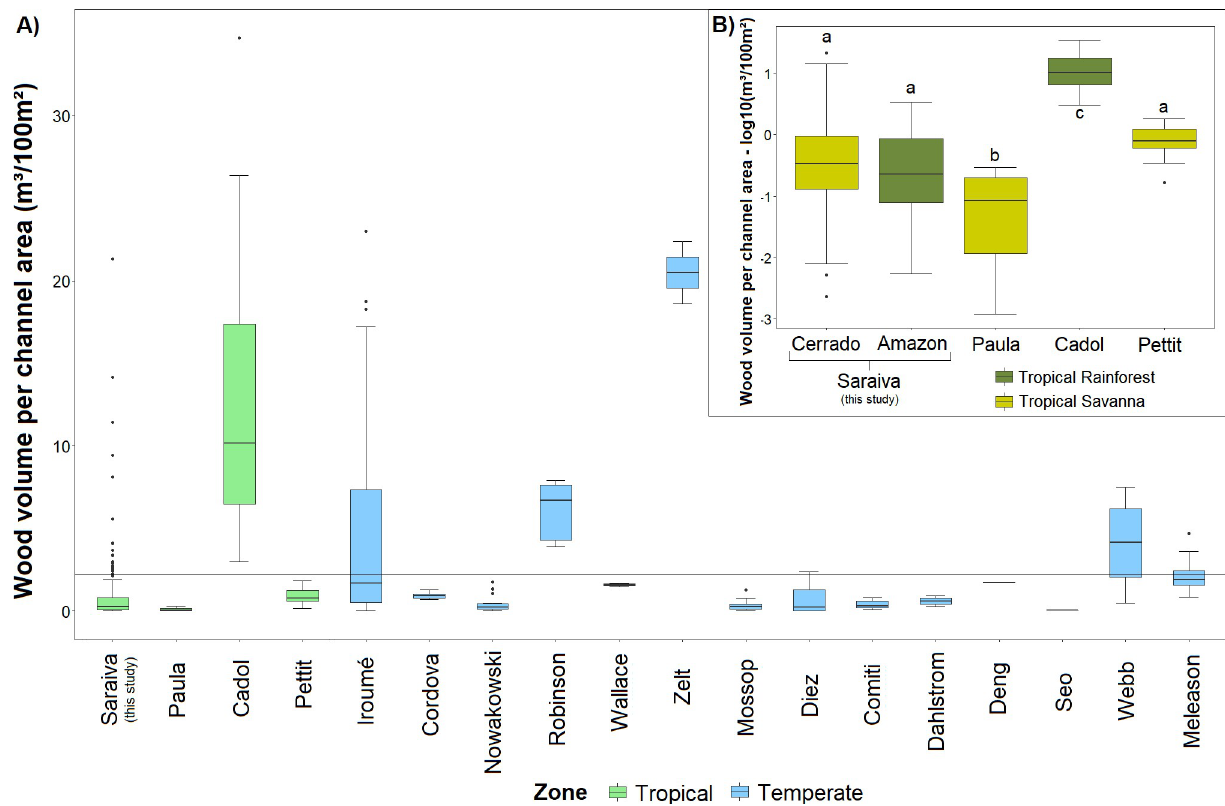
Fig 7. Boxplots of the instream wood volume per study. The instream wood volume averages in other studies available in the world literature in (A) and the n-stream wood volume averages in the tropical zone in (B). Each study is indicated by the name of the first author. In the boxplots the line represents the median, the box is the first (25%) and the third (75%) quartiles, the whiskers extend to the most extreme data point which is no more than 1.5 times the length of the box away from the box, and the black dots are the outliers defined by the ‘1.5 rule’. The box colour indicates the regions where the study is located (the climatic zone in A and the tropical biome in B). Different letters above the whiskers indicate significant mean difference according post-hoc Tukey